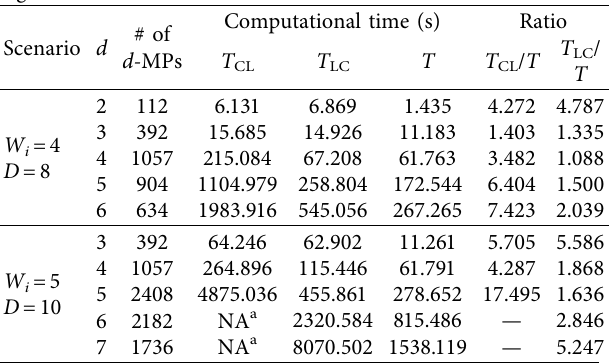
Table 4: Results of different algorithms for solving the network in Figure 4. Scenario